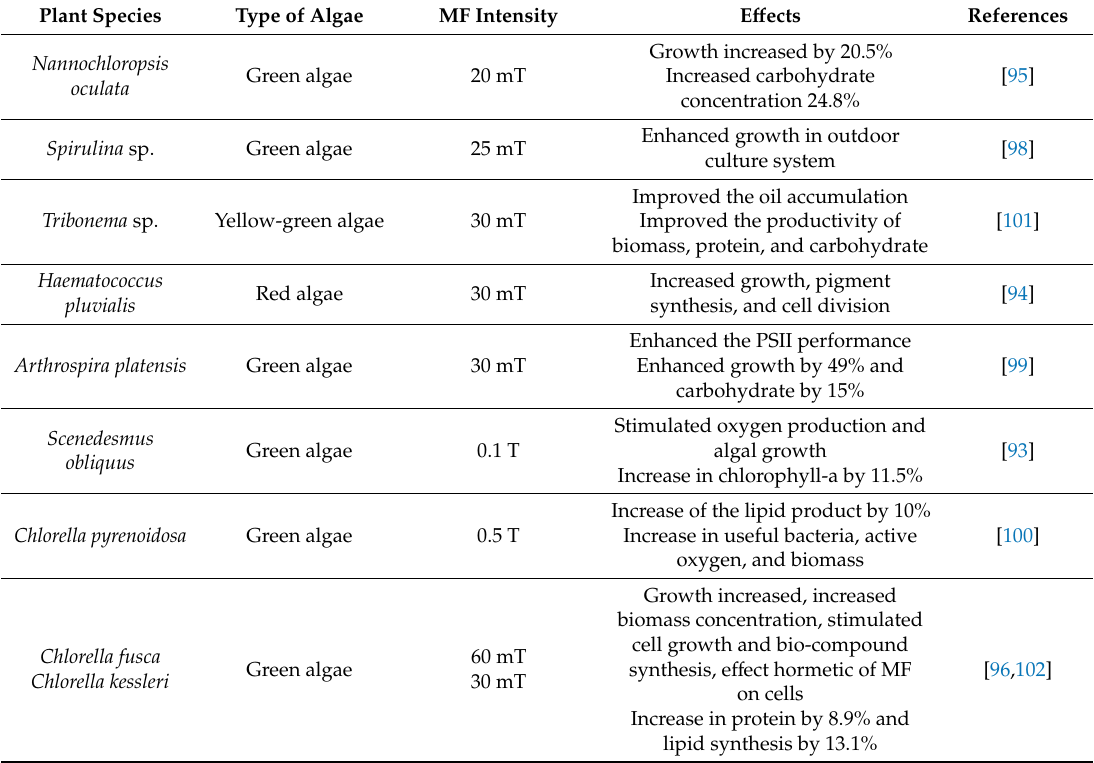
Table 4. E ff ect of magnetic field on algae